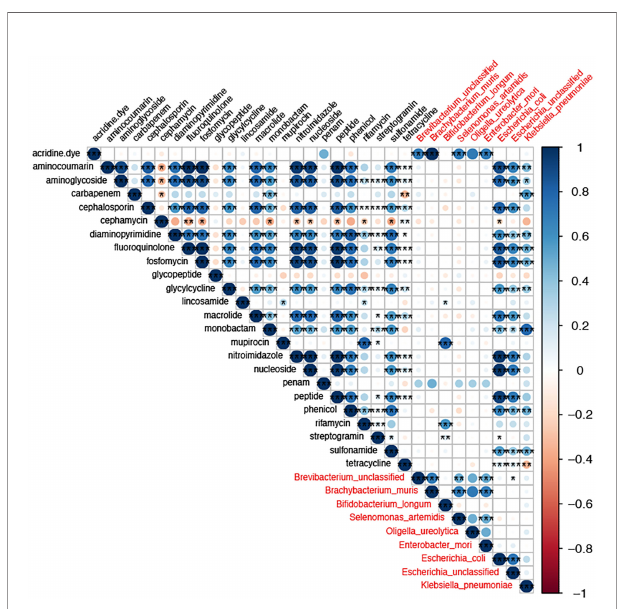
FIGURE 8 | The correlation between drug resistance genes and gut strains. The size of the circle size represents the strength of the correlation and the color denotes a positive or negative correlation. The names of drug resistance genes are shown in black, and the names of bacteria are shown in red. * P- value <0.05,** P-value <0.01, and *** P-value